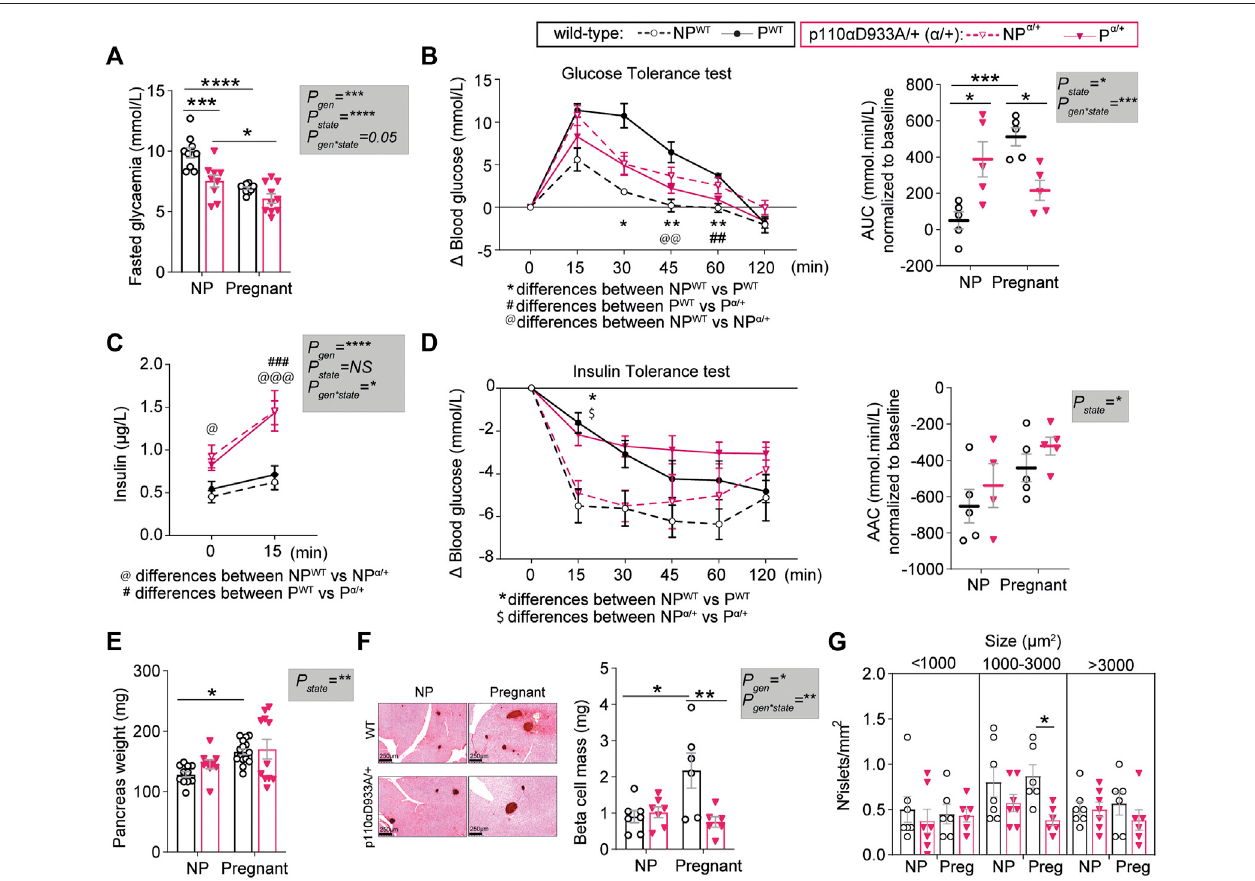
FIGURE2 | PI3K-p110 α regulatesglucosehomeostasisand participates in the expansion of pancreatic β -cellmassin responseto pregnancy. (A) Fasted glucose levelsinnon-pregnant(NP)andpregnantmice( n > 5/group;two-wayANOVA). (B) Glucosetolerancetestandareaunderthecurve(AUC)afterintraperitonealinjectionof glucose( n =5/group;GTTcurve analysed bytwo-way repeatedmeasuresANOVA; AUCanalysedbytwo-way ANOVA). (C) Fasted insulinlevels forGTTanimals before administrationofglucoseattime0and15 minafterintraperitonealinjectionofglucose( n =4 – 5/group;two-way MIXEDANOVA). (D) Insulintolerance testandarea above the curve (AAC) after intraperitoneal injection of insulin ( n = 4 – 5/group; ITT curve analysed by two-way repeated measures ANOVA; AAC analysed by two-way ANOVA). (E) Pancreas weight ( n = 9 – 15/group; two-way ANOVA). (F) Representative images of insulin staining using DAB for pancreas islet detection (scale bar = 250 μ m)and β -cellmass( n =6 – 7/group;two-wayANOVA). (G) Distributionofisletssizesperareaanalysed( n =6 – 7/group;two-wayANOVA).Dataareindividualvalues and/or mean ± SEM. * p < 0.05; ** p < 0.01; *** p < 0.001; **** p < 0.0001. For B and D, the de fi nitions for *, @, $ and # are provided within the fi gure.